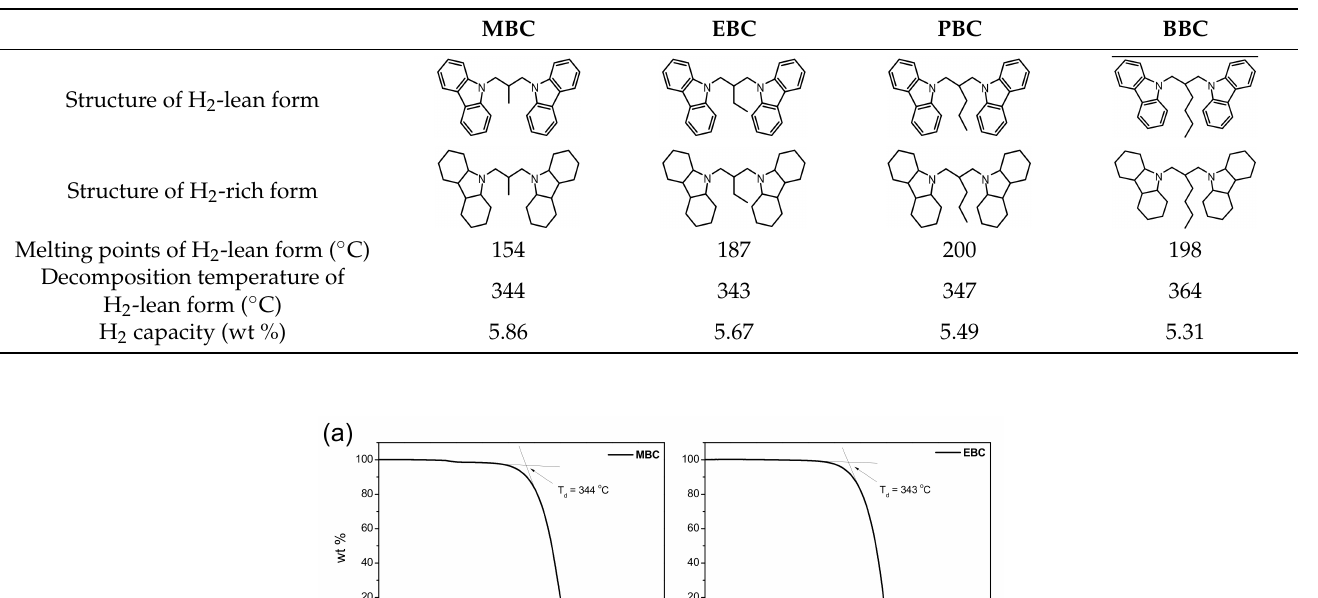
Table 1. Relevant properties of MBC , EBC , PBC , and BBC .